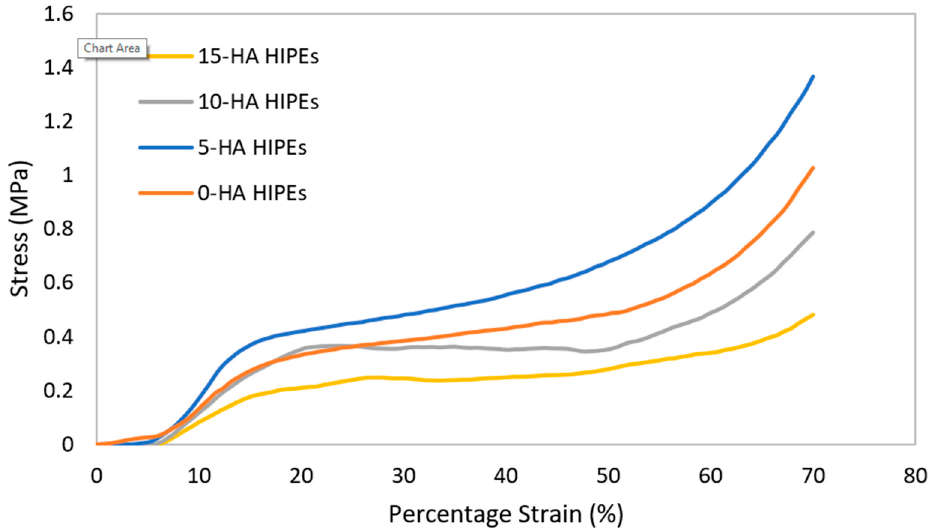
Figure 9. Stress–strain curve of poly(TT/DPEHA)HIPEs with various amount of HA.